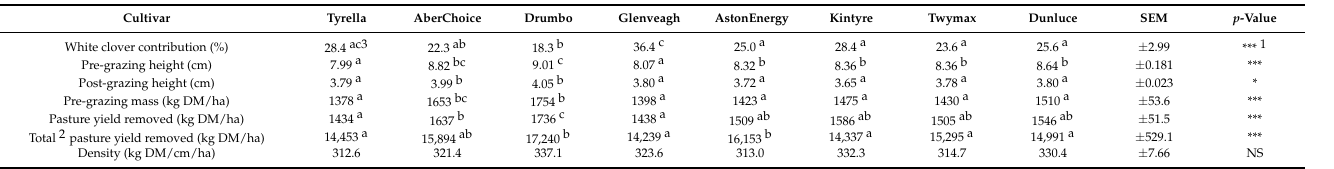
Figure 1. Annual white clover contribution of individual PRG cultivars. The grazing management variables of note for the diploid and tetraploid PRG cultivars are presented in Table 3. There were no differences between the tetraploid cultivars for any of the variables with the exception of total pasture yield removed for AstonEnergy, as it had a higher pasture yield removed than Kintyre, Twymax and Dunluce. Pre- and post-grazing height, PrGPM and pasture removed were significantly lower for Tyrella and Glenveagh than AberChoice and Drumbo. Total pasture removed was significantly lower for Tyrella and Glenveagh than for Drumbo with AberChoice intermediate and not distinct. There were no significant differences in density between all the cultivars. Table 3. Grazing characteristics of diploid perennial ryegrass and the mean of the tetraploid perennial ryegrass cultivars used over 4